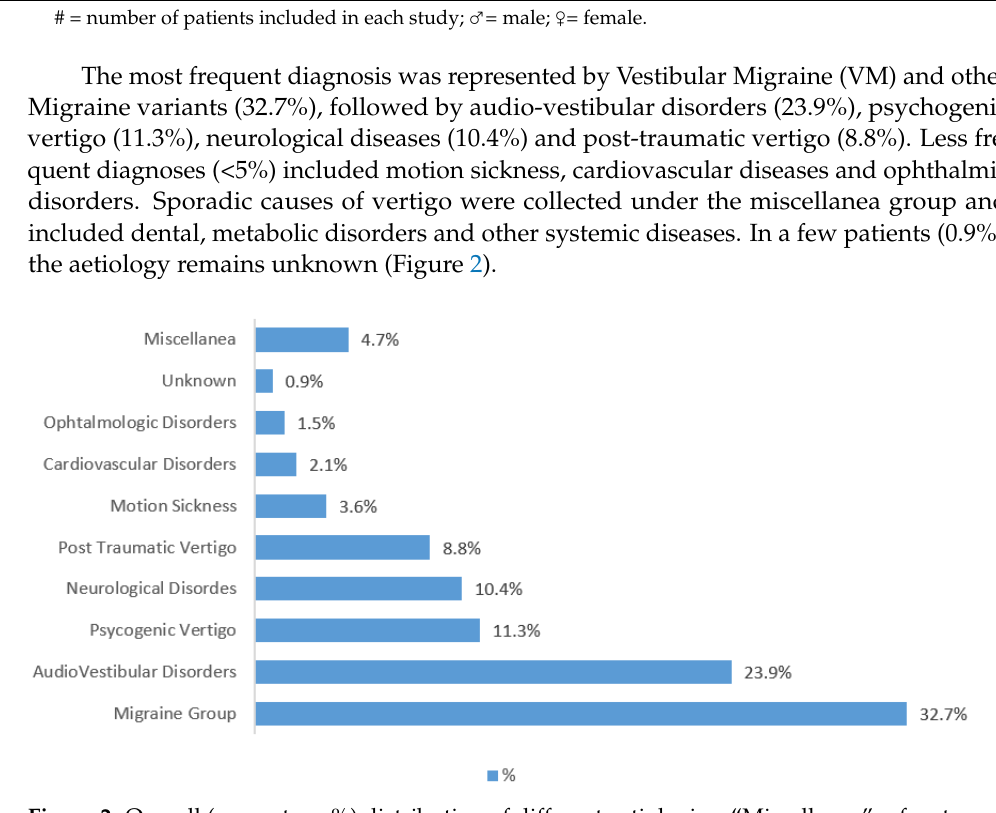
Figure 3. Distribution of different diagnoses according to age. “Mix” refers to a cumulative % of sporadic diagnoses and non-otherwise specified diagnoses. Migraine-related vertigo was the most frequent diagnosis, independently of the age group. Among the migraines, VM was the most represented aetiology (71%), followed by Benign Paroxysmal Vertigo of Childhood (BPVC) and other migraine variants, such as basilar migraine or hemiplegic migraine. (Figure 4a). Further analysis of the distribution of VM and BPVC according to age is presented in Figure 4b.